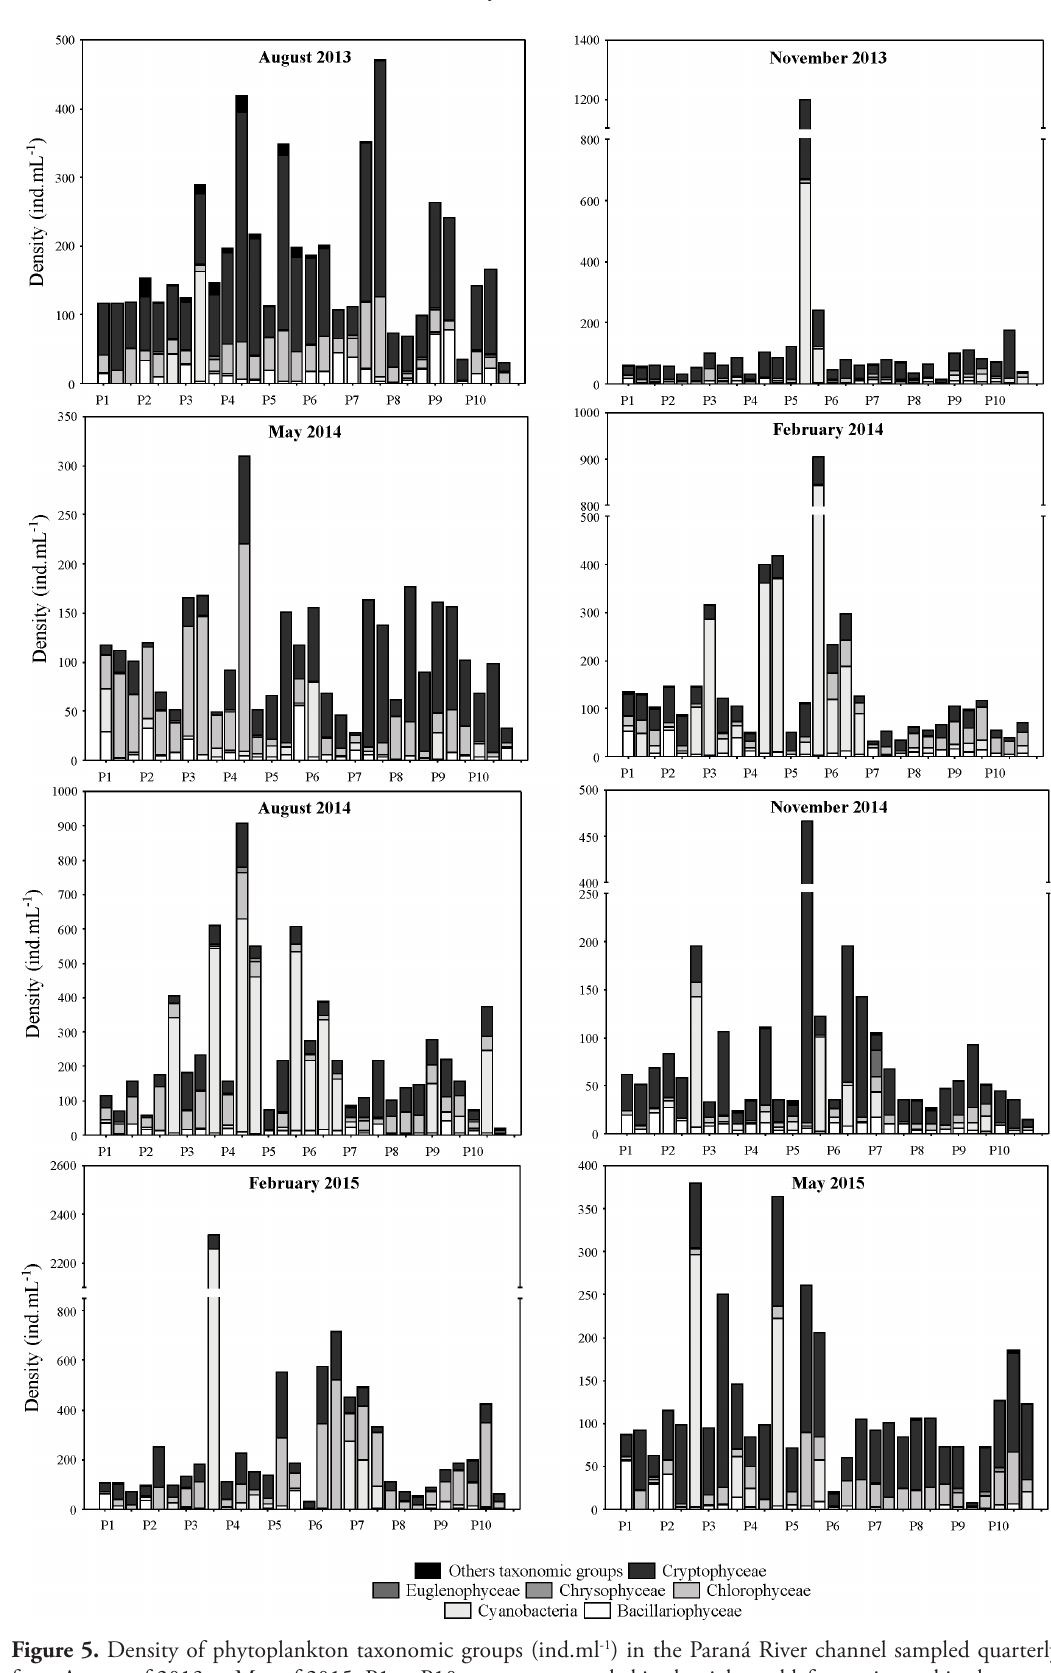
Figure 5. Density of phytoplankton taxonomic groups (ind.ml -1 ) in the Paraná River channel sampled quarterly from August of 2013 to May of 2015. P1 to P10 - transects sampled in the right and left margins and in the center of the Paraná River main